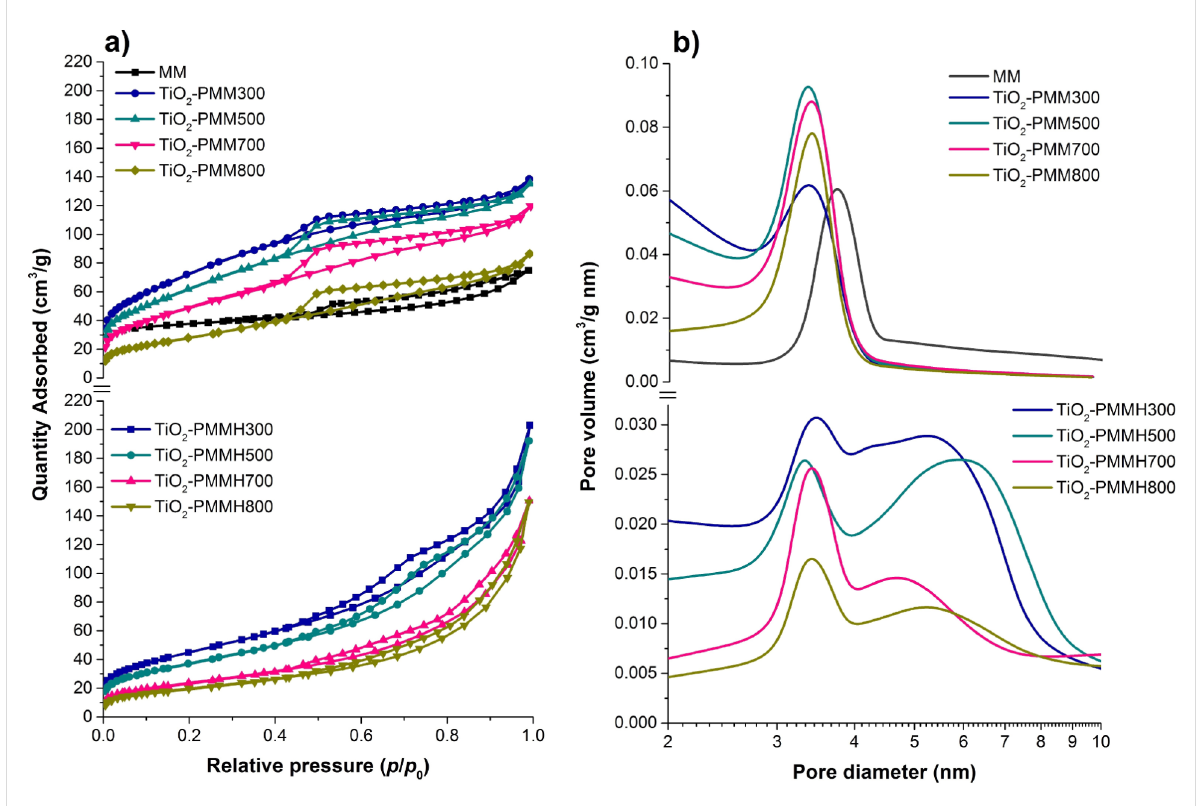
Figure 6: Nitrogen adsorption/desorption isotherms ( а ) and pore size distribution (b) of the raw MM, TiO 2 -PMM x , and TiO 2 -PMMH x .